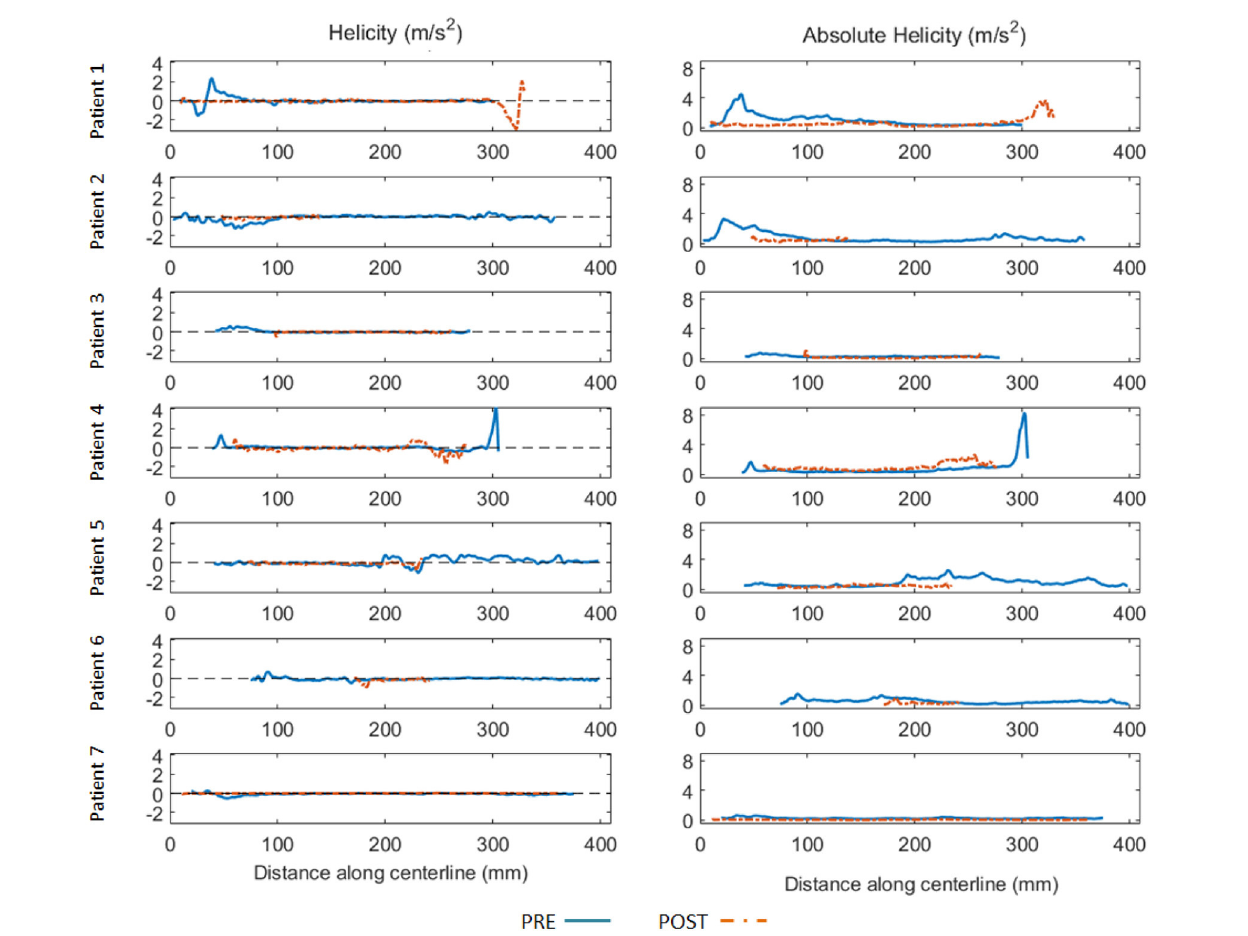
FIGURE 2 | Helicity (left) and absolute helicity (right) plots obtained in the false lumen along the aorta centerline (spaced 1mm apart) for all patients before (blue full line) and after TEVAR (orange dashed line). Horizontal axis indicates the distance (in mm) along the centerline with respect to the same anatomical reference location (5cm above the aortic sinus). To be noted the elevated helicity in the proximal part of the false lumen for Patient 1 and Patient 2, indicating significant blood circulation through the entry tears. Elevated helicity was also observed in the distal part of the false lumen, related to one significant re-entry tear at the coeliac truncus (Patient 4) and to several entry tears in a patient with identified Marfan syndrome (Patient 5). Helicity decreased significantly post TEVAR in the proximal part of the false lumen for all patients. Oppositely, helicity increased in the distal part for 2 patients (Patient 1 and